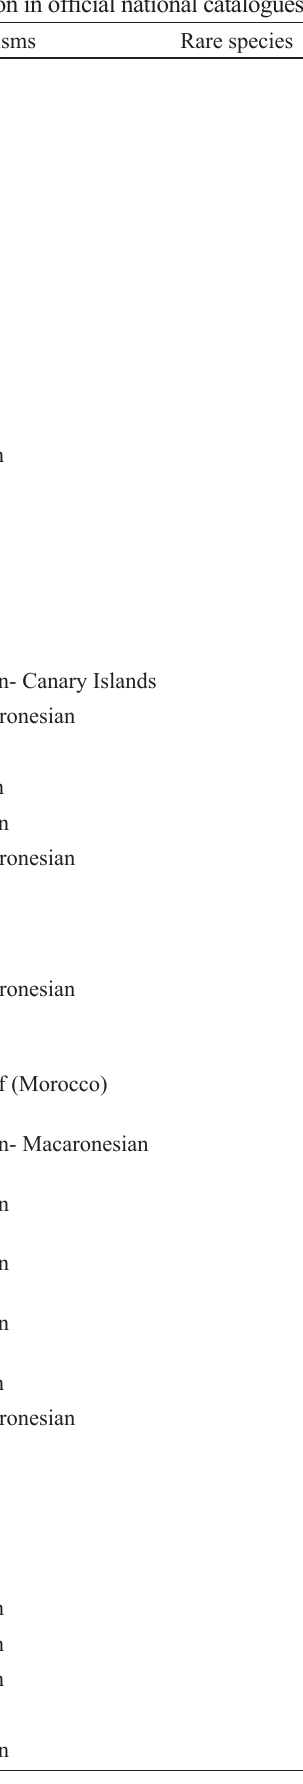
Table 1. Endemic or rare bryophytes present in Spanish territory. Species marked (*) are not included in the proposal due to insufficient information or because they are not considered as threatened. Syntrichia abranchesii (**) is